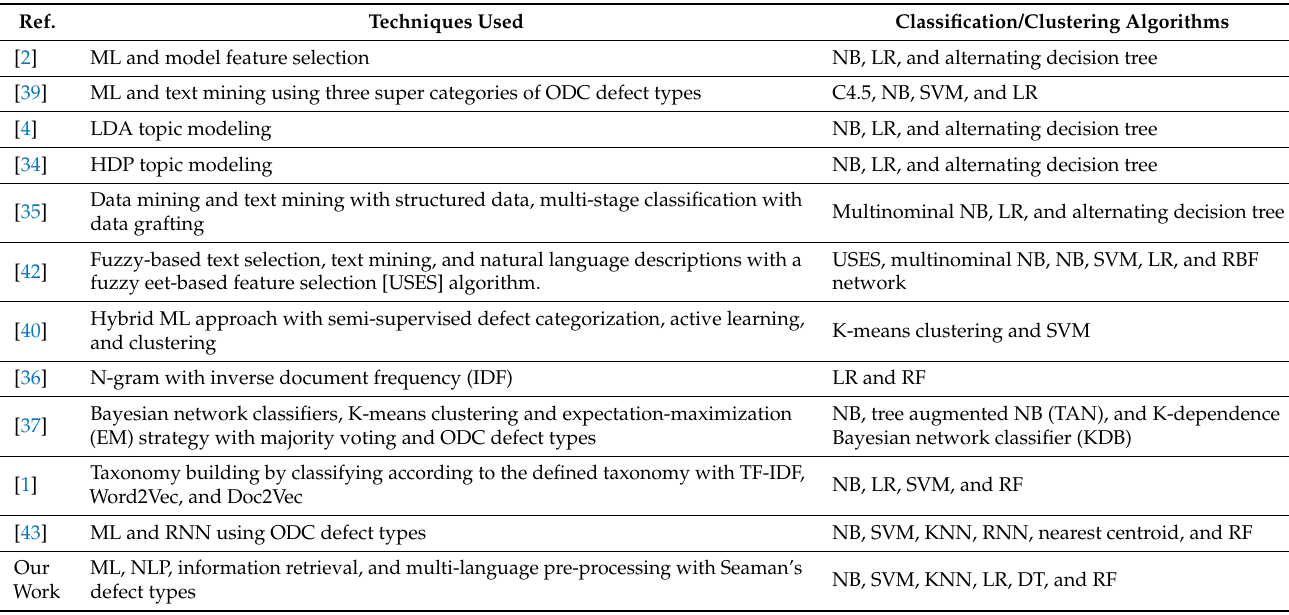
Table 13. Comparison of automatic bug classification